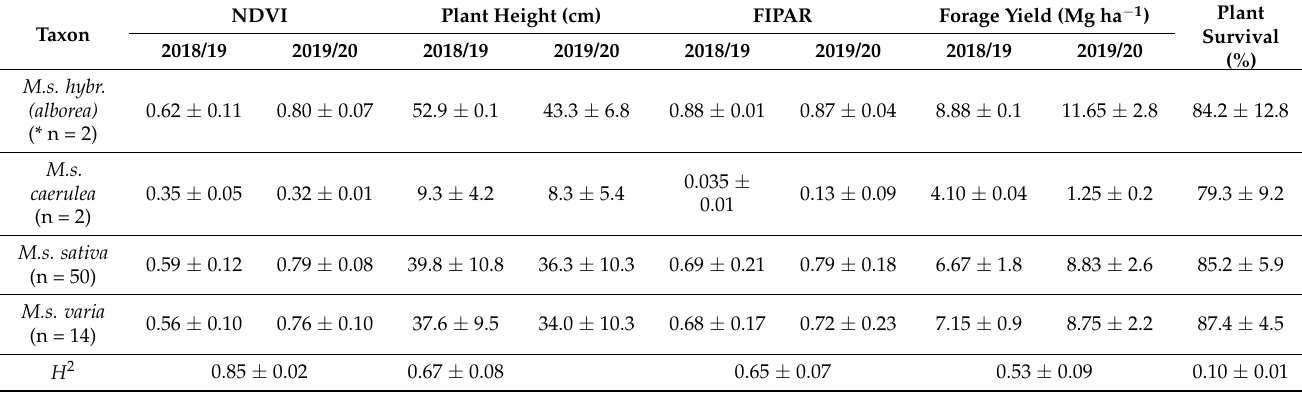
Table 1. Mean ± standard deviation and broad sense heritability ( H 2 ± SE) of plant survival, normalized difference vegetation index (NDVI), plant height, fraction of intercepted photosynthetic active radiation (FIPAR) and dry matter production, evaluated in an alfalfa diversity panel including accessions belonging to four subspecies M. sativa subsp. sativa , M. sativa subsp. caerulea , M. sativa subsp. varia and M. sativa subsp. alborea . Phenotypic characterization was performed during two growing seasons (2018–2019 and 2019–2020) in a Mediterranean drought-prone environment in